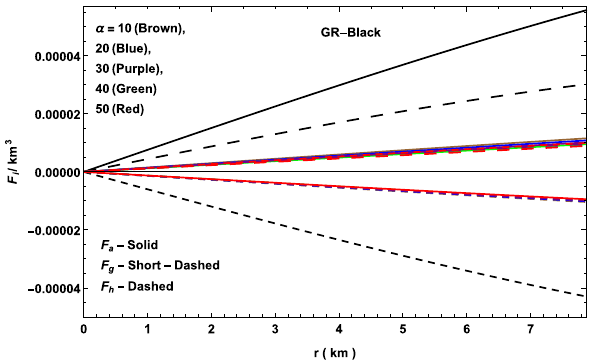
Fig. 11 Variation of various forces in TOV-equation for 4U 1538-52 using the parameter provided in Table 1